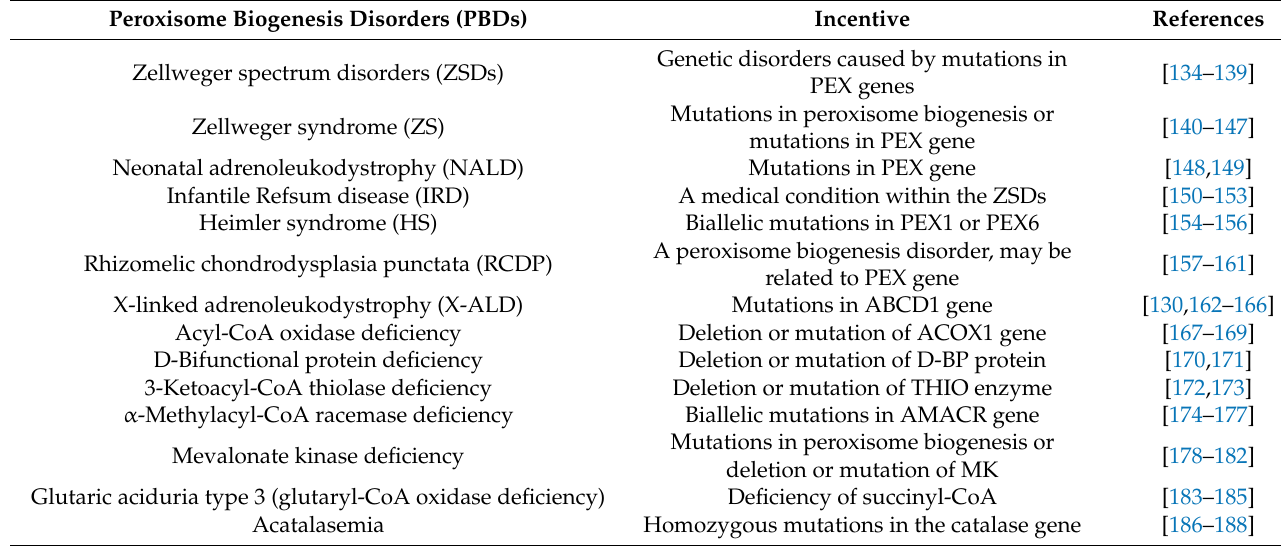
Table 1. Major diseases in